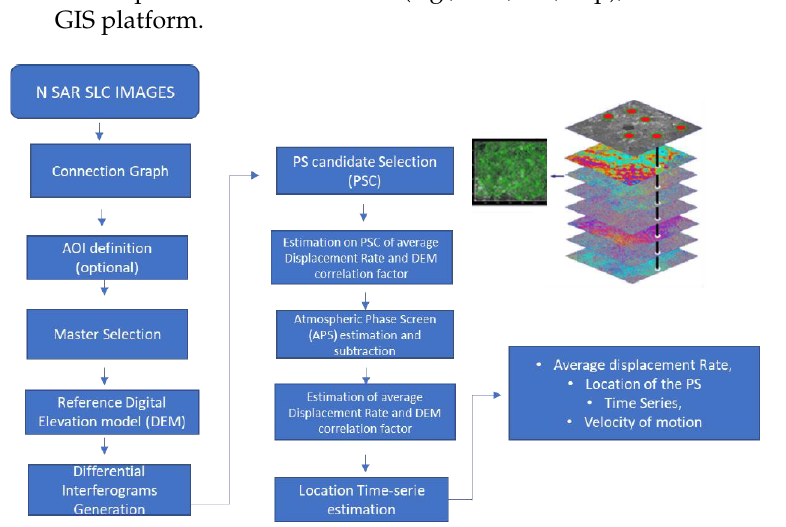
Figure 7. Processing steps of the persistent scatterer interferometry analysis.